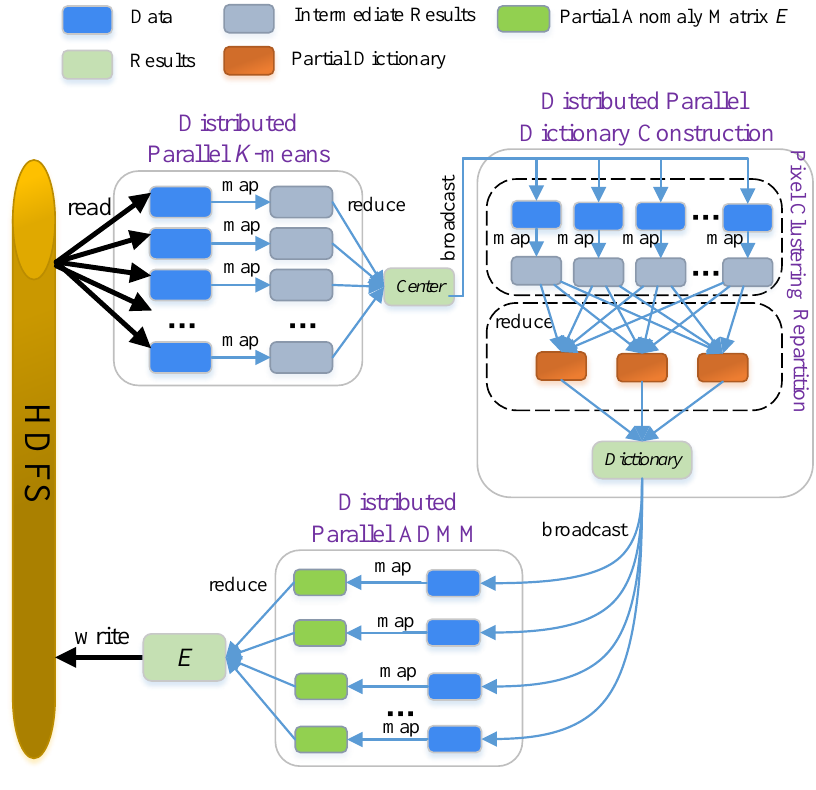
Figure 3. Flowchart of